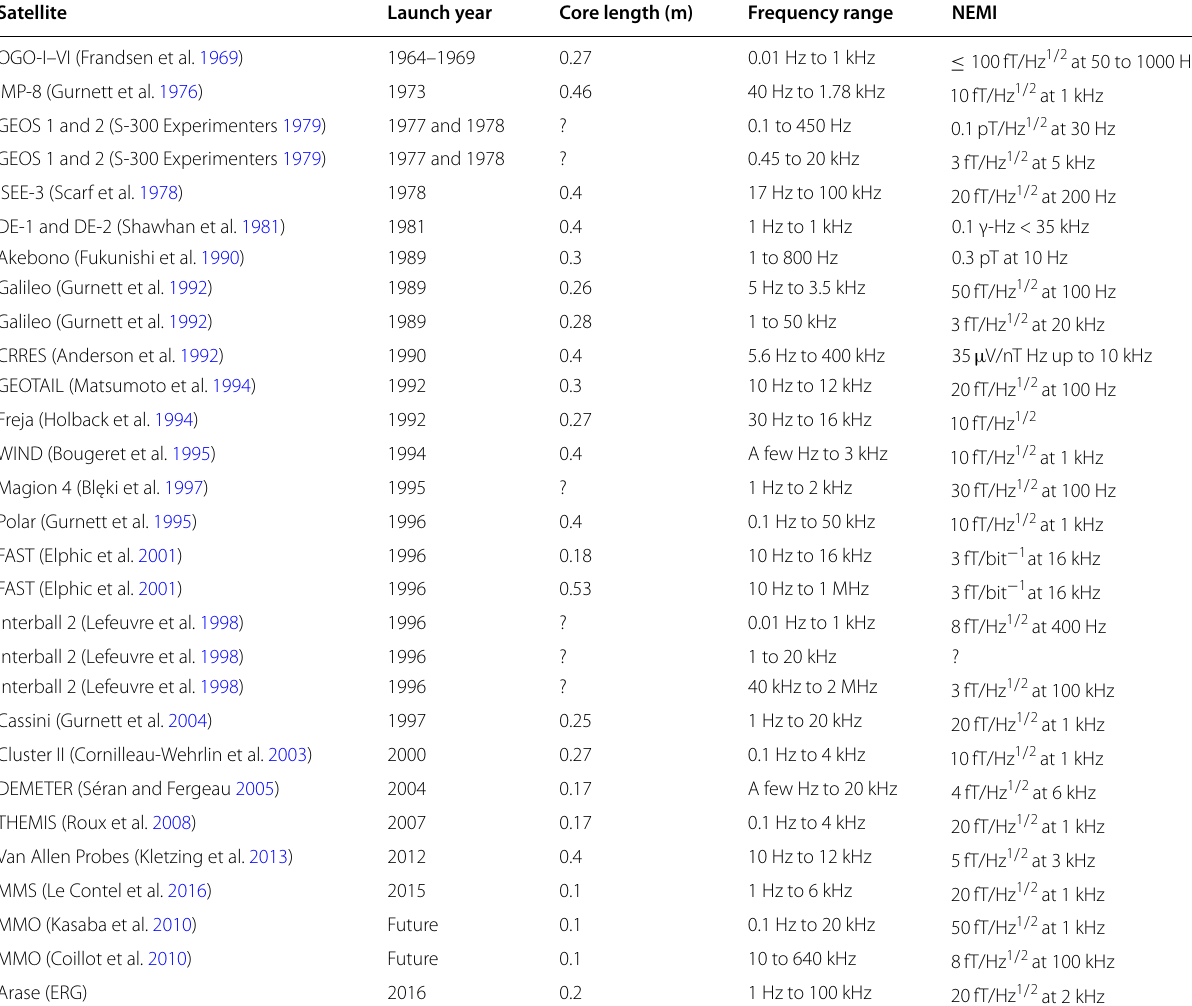
Table 1 Major examples of spaceborne search coil magnetometers for plasma wave measurements